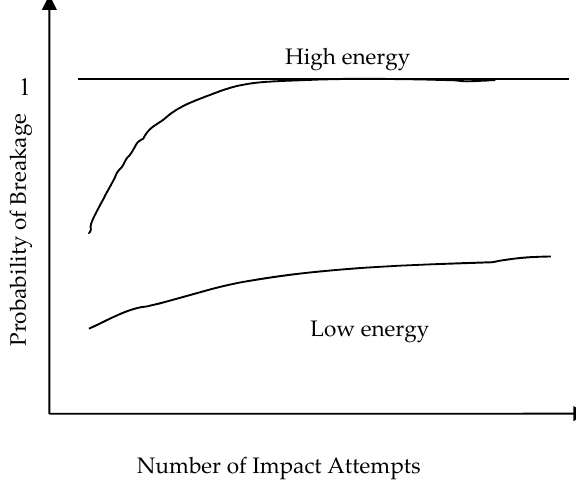
Figure 2. The influence of energy input and breakage attempts required to break a particle.